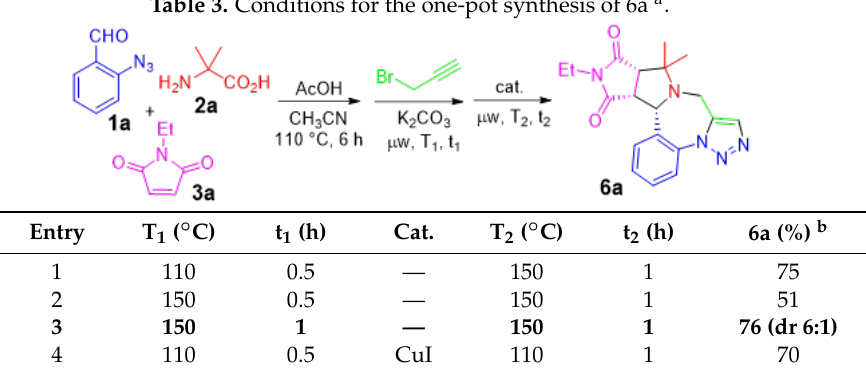
Table 3. Conditions for the one-pot synthesis of 6a a .